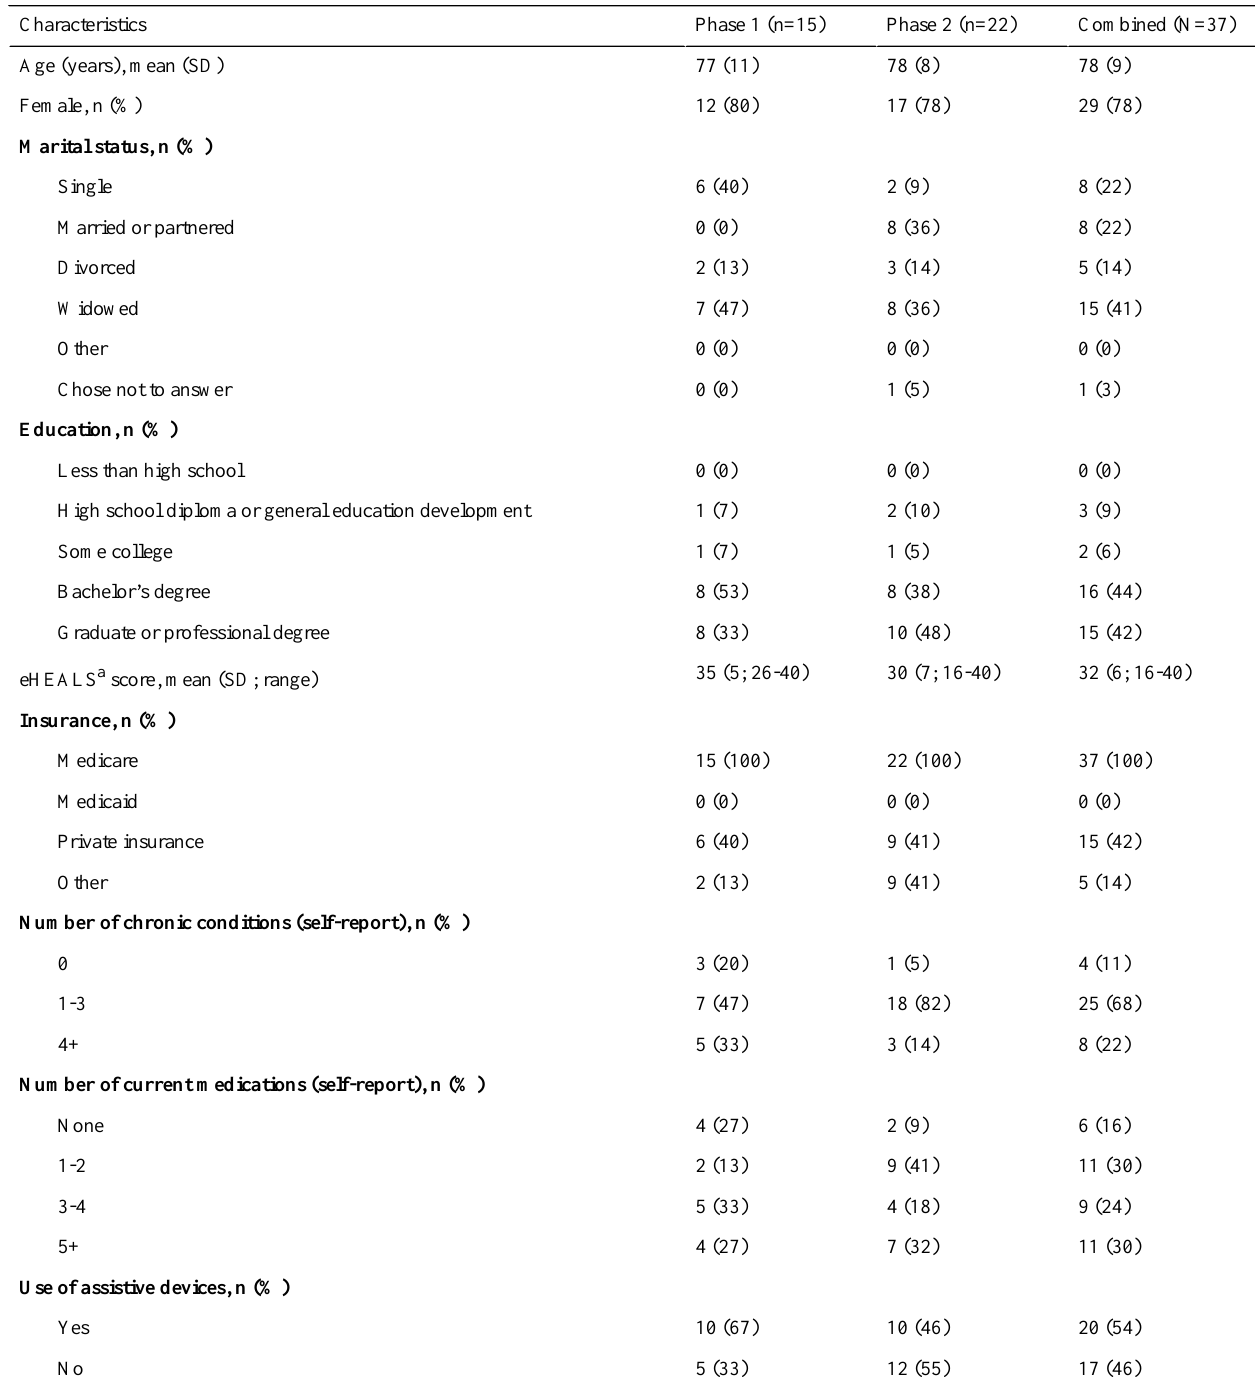
Table 4. Participant